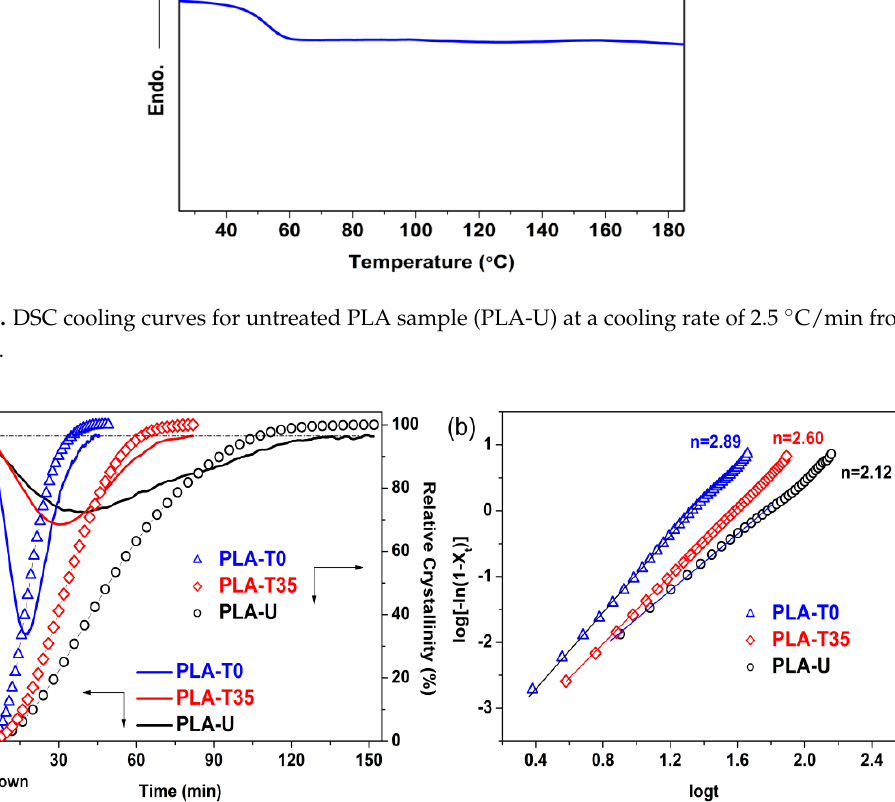
Figure 2. ( a ) DSC traces and variation of relative crystallinity with crystallization time for PLA-U, PLA-T35, and PLA-T0 at 110 °C and ( b ) the corresponding Avrami plots. Table 1. Summary of isothermal crystallization kinetics at 110 ◦ C for PLA-U, PLA-T35, and PLA-T0 samples. Summary of Crystallization Sample